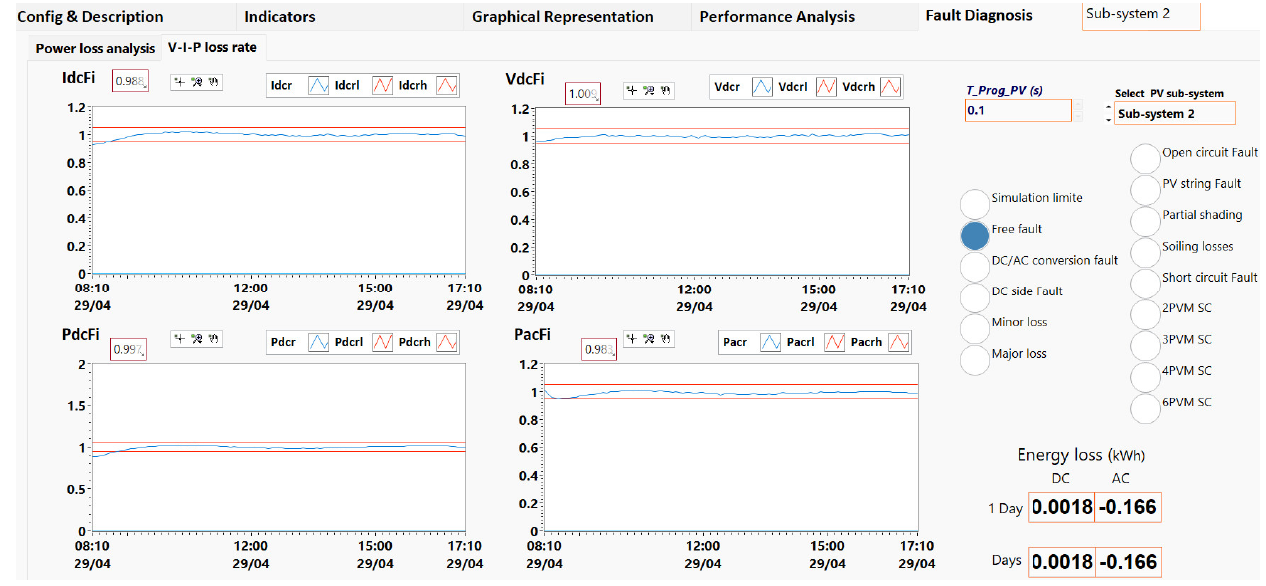
Figure 21. Designed fault diagnosis interface _Free fault case 29042020 sub-system 1.